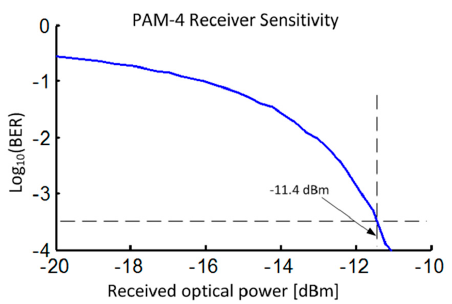
Figure 4. Receiver bit-error rate (BER) performance for 28 Gbaud PAM4. The ER is 7.6 dB. The sensitivity at BER 3 × 10 − 4 occurs at − 11.8 dBm.